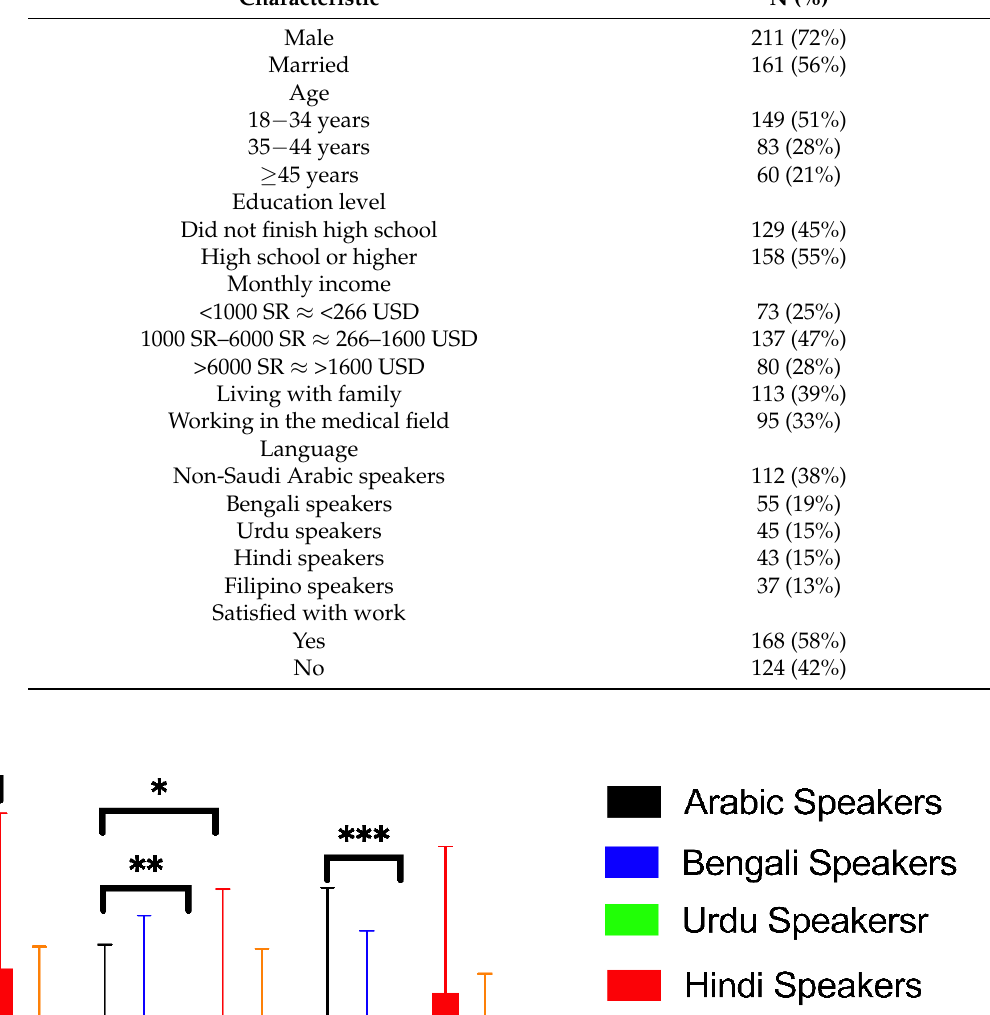
Table 1. Sociodemographic characteristics of the respondents (N = 292).